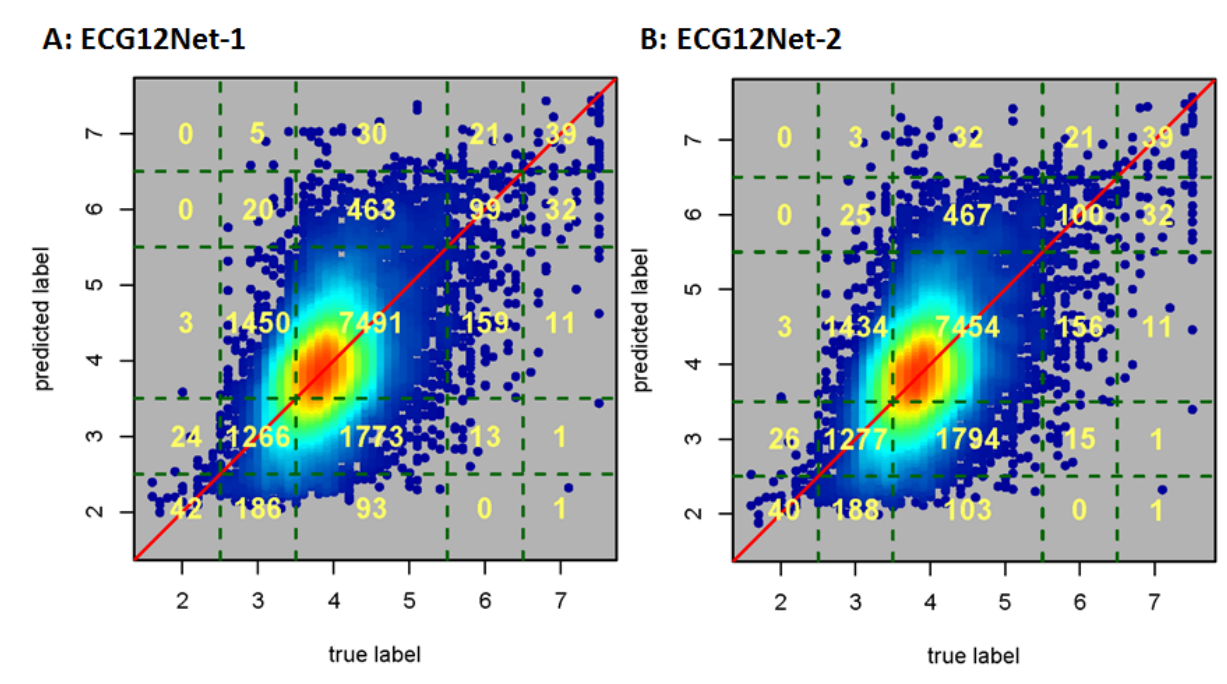
Figure 3. Confusion scatter plots of ECG12Net-1 and ECG12Net-2 predictions on the test set (n=13,222). The x-axis indicates the true K+ concentration from laboratory testing. The y-axis presents the predicted K+ concentration by ECG12Net-1 (A) and ECG12Net-2 (B). Red points represent the highest density, followed by yellow, green, light blue, and dark blue. Perfect model performance would fall only along the red diagonal line. We categorized the K+ concentration into five groups (K + ≤ 2.5 mEq/L, 2.5< K + ≤ 3.5 mEq/L, 3.5< K + <5.5 mEq/L, 5.5 ≤ K + <6.5 mEq/L, and K + ≥ 6.5 mEq/L) and calculated the case counts in each